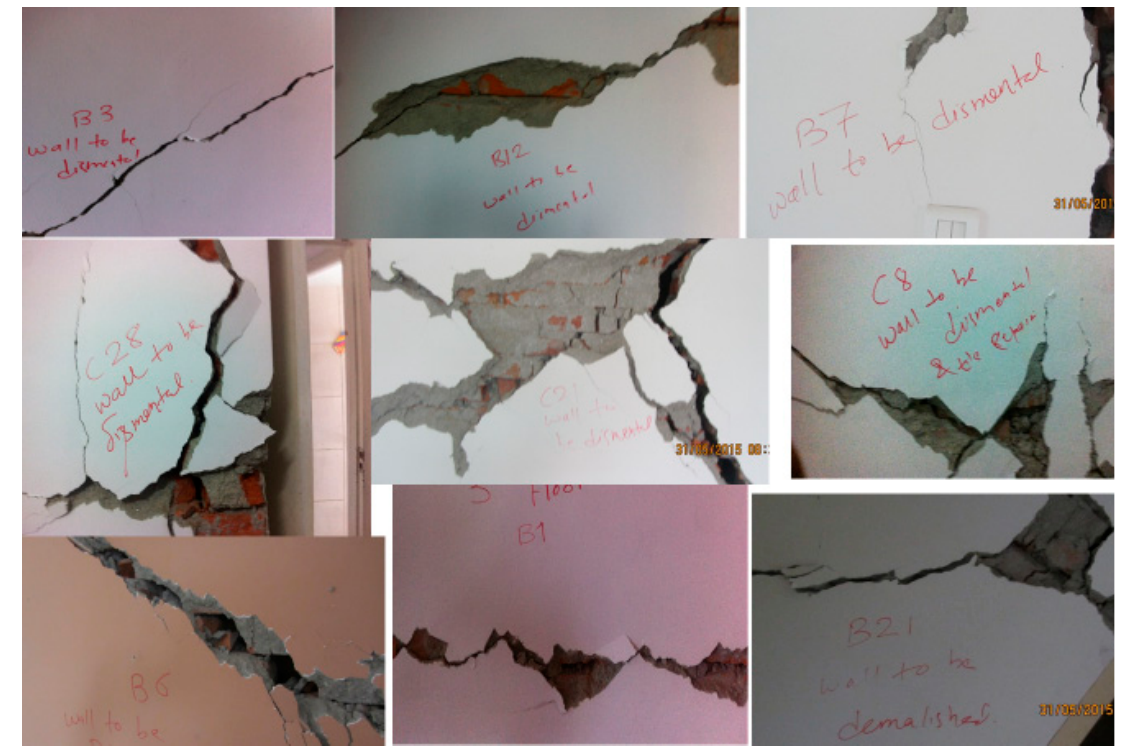
Figure 6. Infill wall damage due to Gorkha earthquake in the case study building.